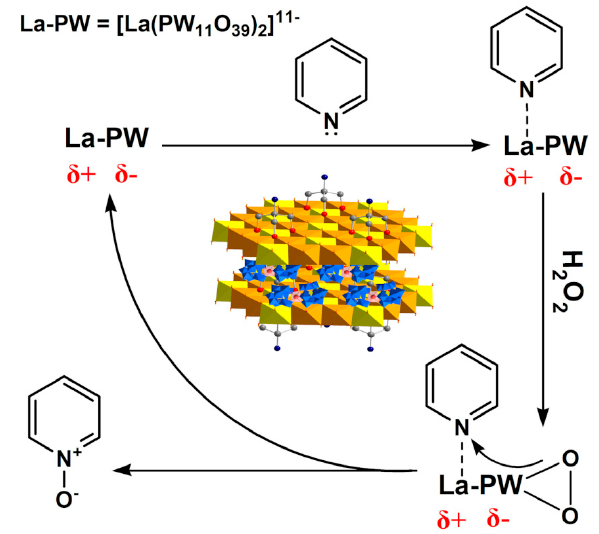
Figure 9. Proposed reaction mechanism for oxidation of pyridines by Tris ‐ LDH ‐ La(PW 11 ) 2 . Adapted from Ref. [56]. Copyright 2015, from Ref. [56]. Copyright 2015, Willey ‐ VCH.